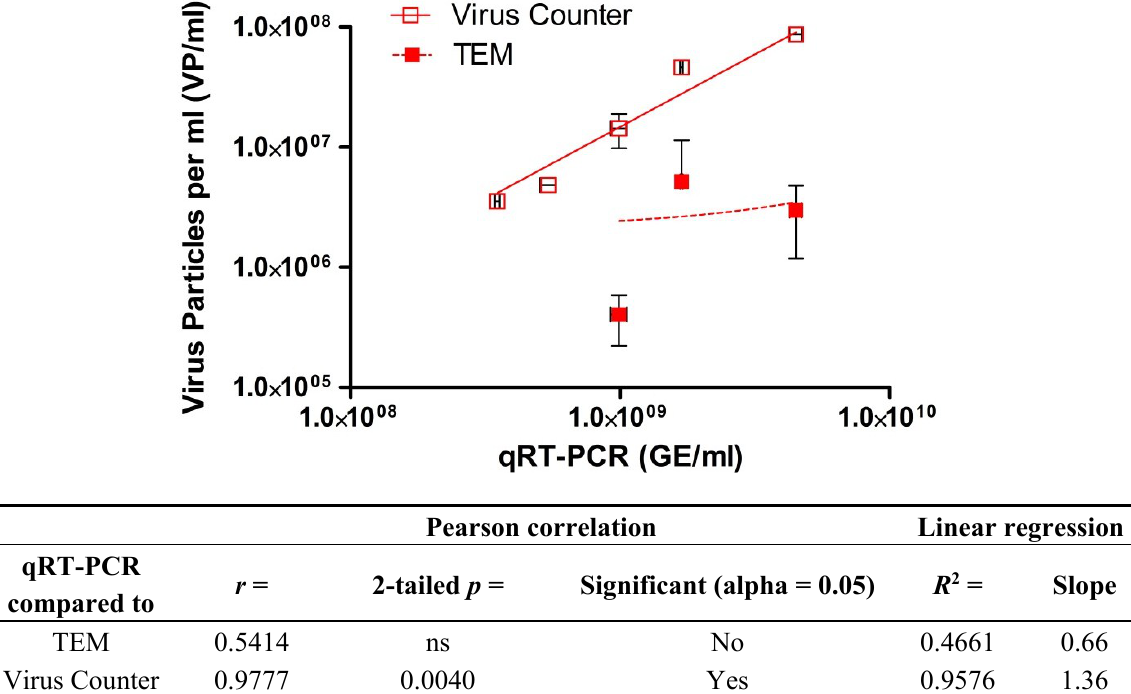
Figure 4. Log-log plot for a dilution series of Ebola virus (EBOV), Kikwit variant, stock virus. Reported nucleic acid concentration (genomic equivalents per mL) for each sample as measured by a EBOV-specific qRT-PCR was compared to the reported virus particle counts per mL measured using the ViroCyt ® Virus Counter 2100 instrument and transmission electron microscopy (TEM). All samples were tested in triplicate; bars represent standard